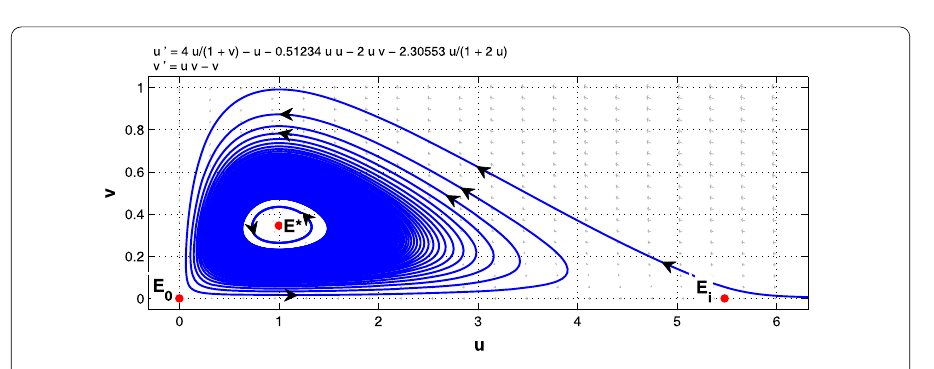
Figure 2 Dynamic behavior of system (1.1) with r 0 = 4, k = 1, d = 1, a = 0.51234, p = 2, E = 1, m 1 = 1, m 2 = 2, c = 0.5, q = 2.30553 = q H , stable periodic orbits bifurcate through Hopf bifurcation around E ∗